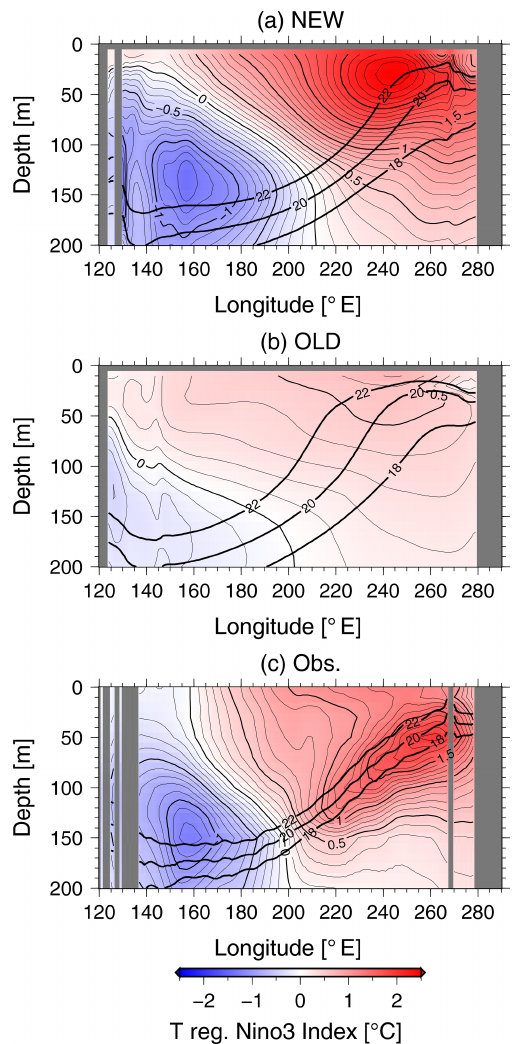
Figure 3. Anomalies of equatorial ocean temperature regressed onto the standardized NINO3-SST anomalies for NEW (a) , OLD (b) , and the observations (c) . The contour interval is 0.1 ◦ C. The thick solid lines indicate the climatological-mean of the 18, 20, and 22 ◦ C